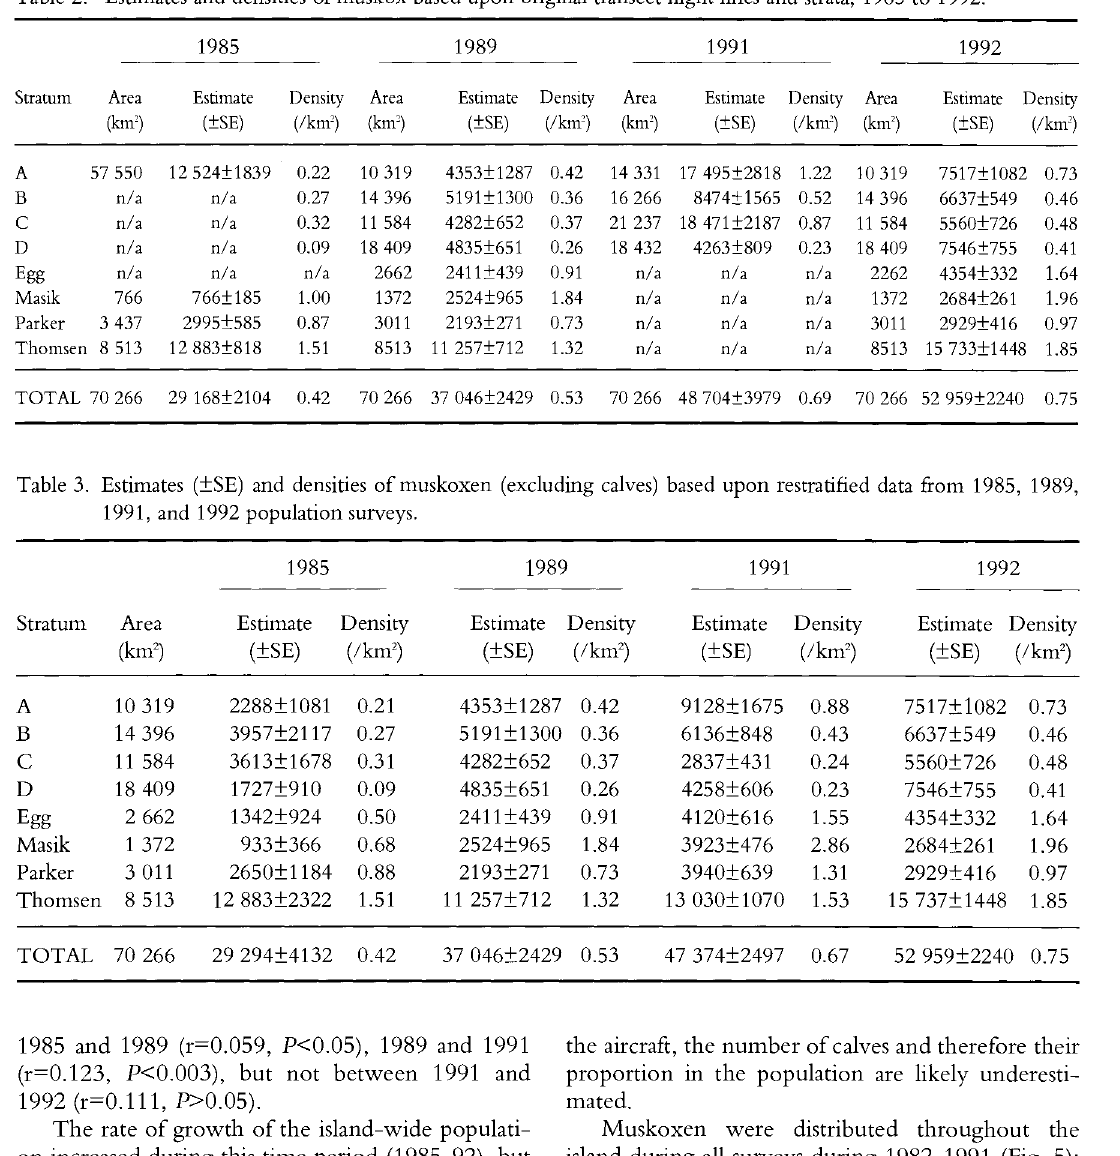
Table 2. Estimates and densities of muskox based upon original transect flight lines and strata, 1985 to 1992.